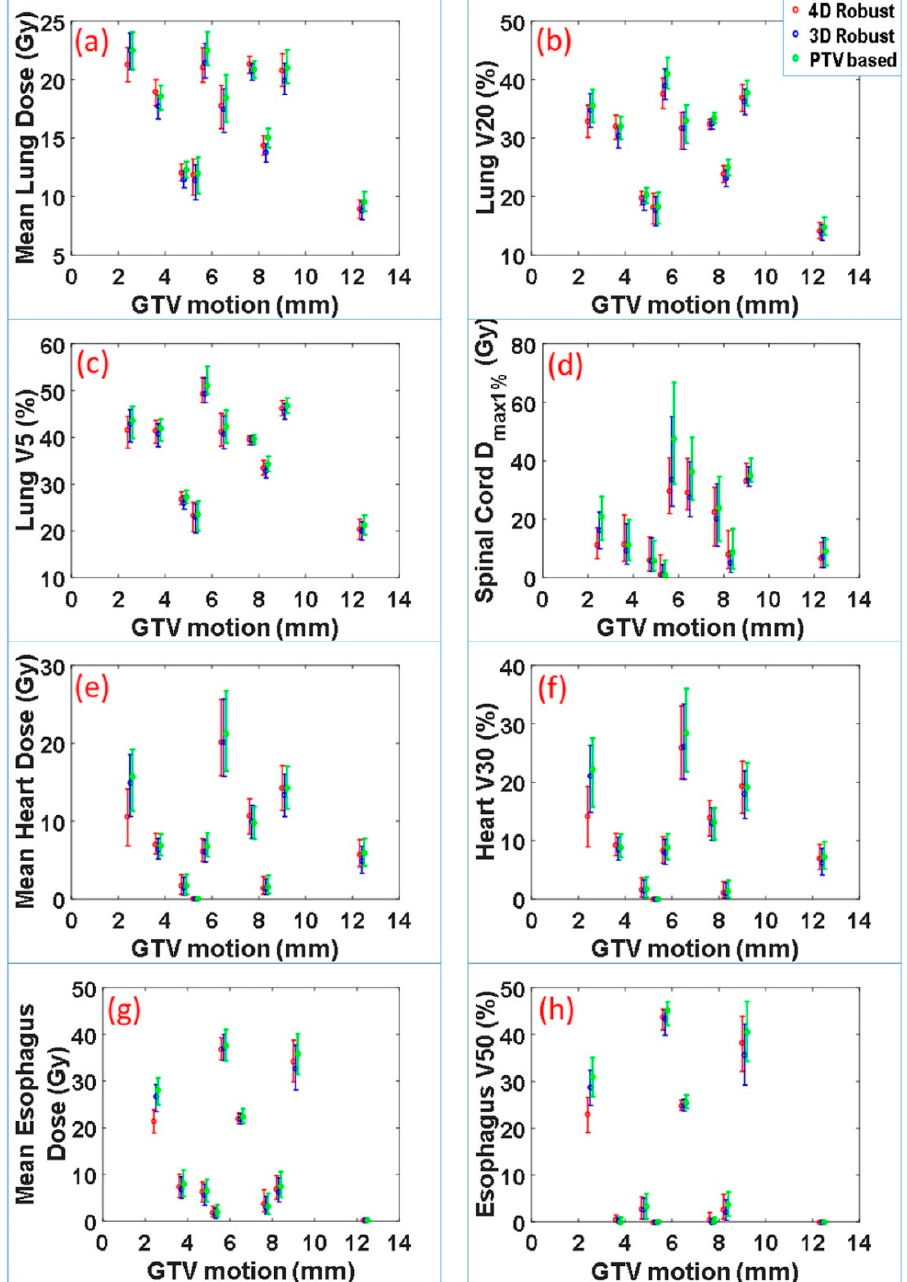
Figure 3. Dose-volume indices of interest for organs at risk. Range and median value of ( a ) mean lung dose, ( b ) lung V20, ( c ) lung V5, ( d ) spinal cord D max1% , ( e ) mean heart dose, ( f ) heart V30, ( g ) mean esophagus dose, and ( h ) esophagus V50 of 90 dose distributions for plans produced with 4DRO, 3DRO and PTV-based optimization vs. GTV motion magnitude.